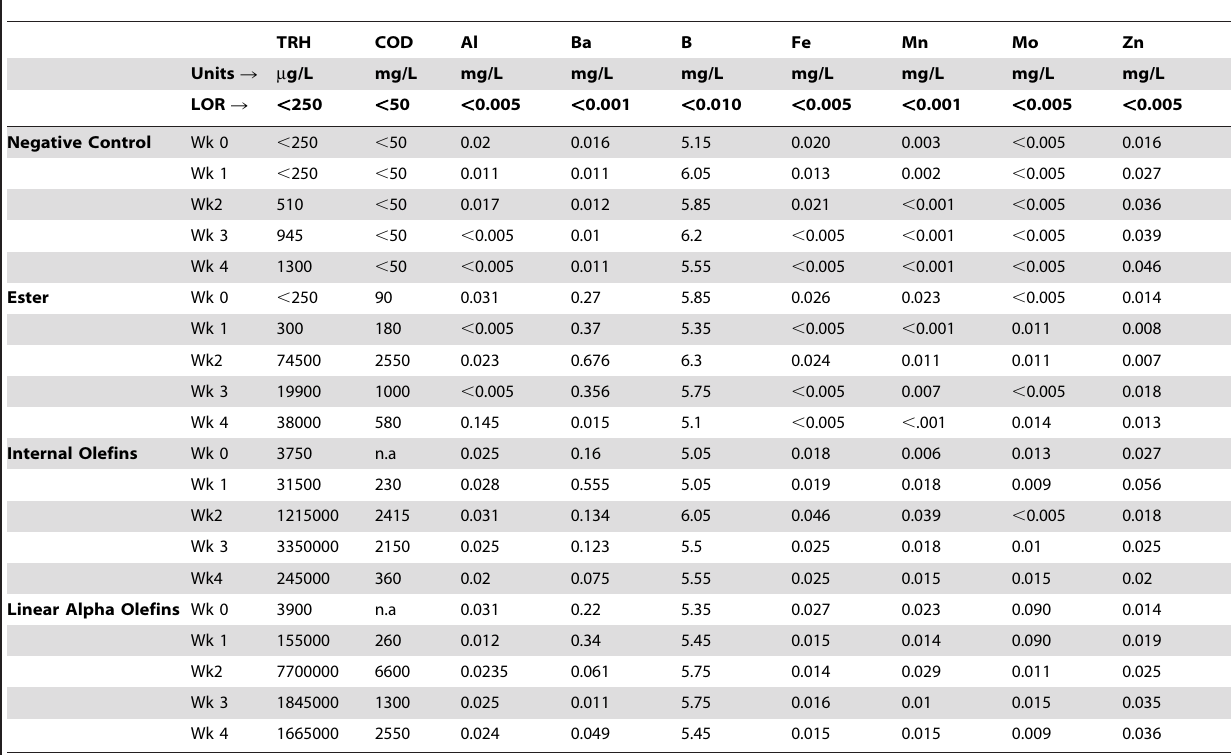
Table 2. Analysis of water samples of Ester, Internal Olefins and Linear Alpha Olefins based SBMs and Negative Control treatments in which juvenile pink snappers were exposed.